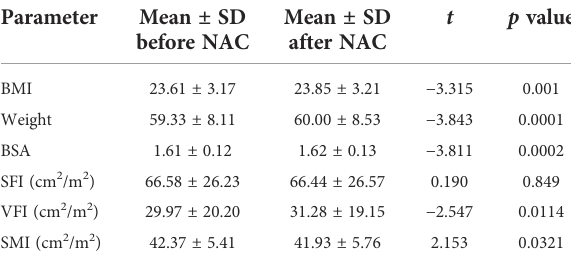
TABLE 2 Body composition changes during neoadjuvant